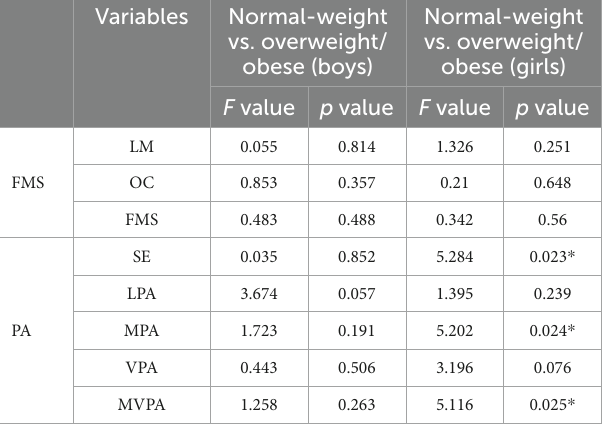
TABLE 4 Normal-weight vs. overweight/obese children’s FMS and PA.